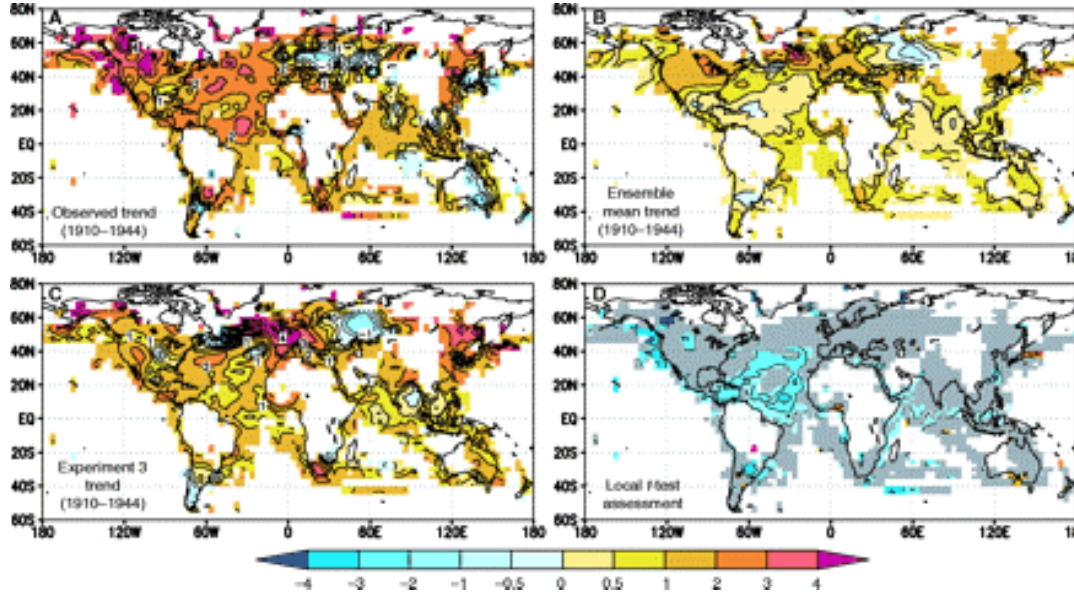
FIGURE 24. Linear trends of surface temperatures (°K/100 years) as labeled. Note agreement between observations and Experiment 3.